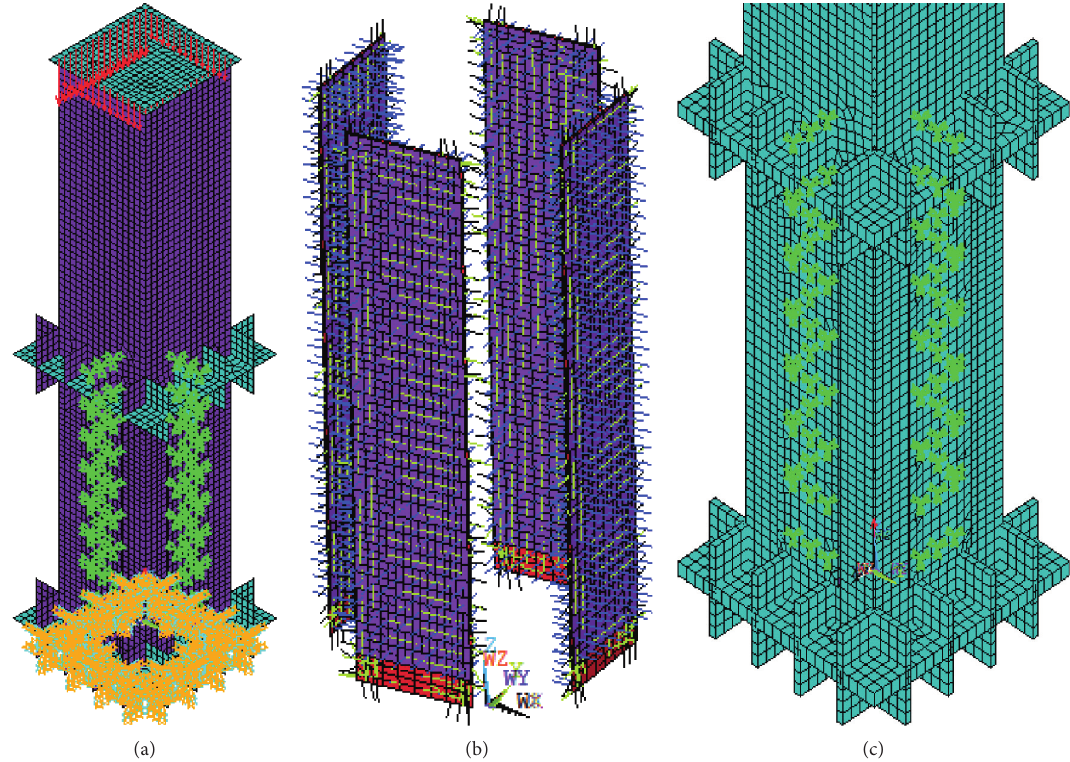
Figure 15: Finite element model. (a) Boundary constraints. (b) Contact pairs on LYP steel plates. (c) Simulation of bolts connection.